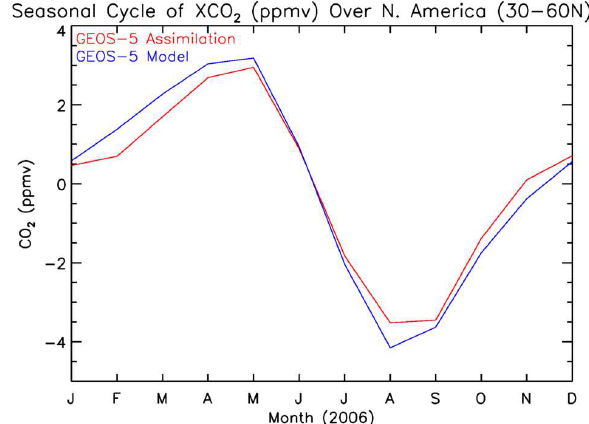
Fig. 16. Seasonal cycle of column-averaged CO 2 mixing ratio Figure 16: Seasonal cycle of column-averaged CO 2 mixing ratio (ppmv) for the assimilation (red) (ppmv) for the assimilation (red) and model (blue) calculated by and model (blue) calculated by detrending time series of monthly mean CO 2 over North America